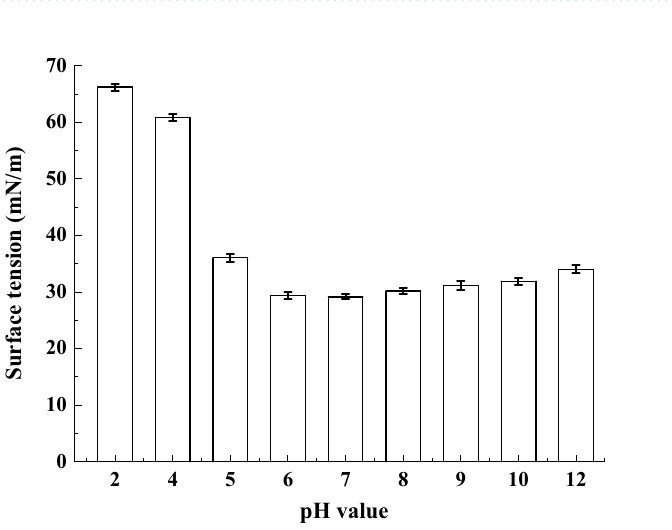
Figure 7. Effect of pH on biosurfactatnt stability produced by B. subtilis